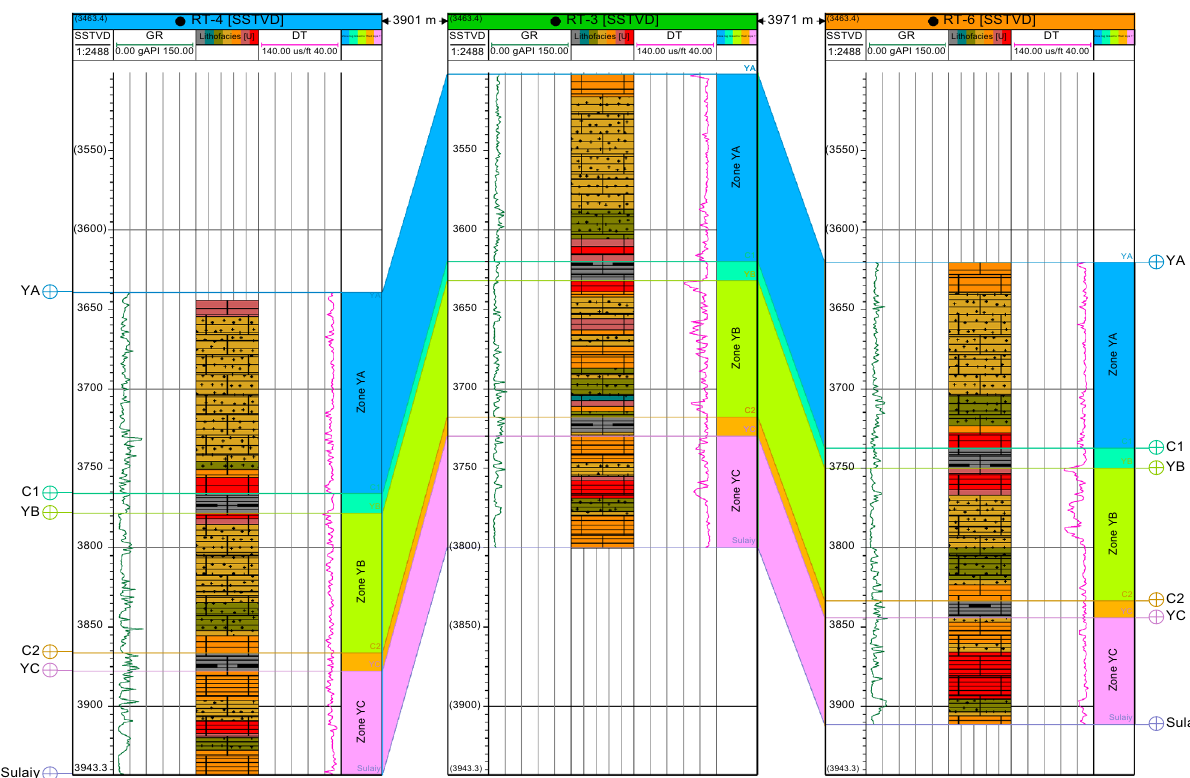
Figure 7. Correlation section in direction East–West passes through the study wells (Rt-4, Rt-3, and